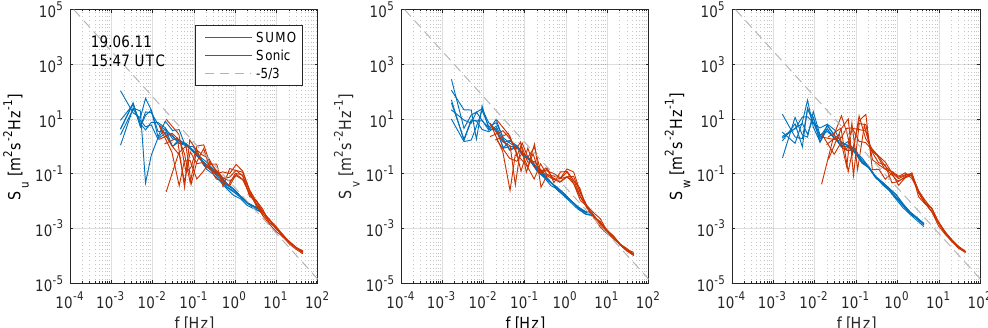
Figure 15. Energy spectra of the velocity variances of the u , v and w component from SUMO (red) and the sonic anemometer at the 60m mast. The data are from flight # 29 on 19 June 2011 around 16:00UTC. The average wind speed was 3.6ms − 1 from 317 ◦ .